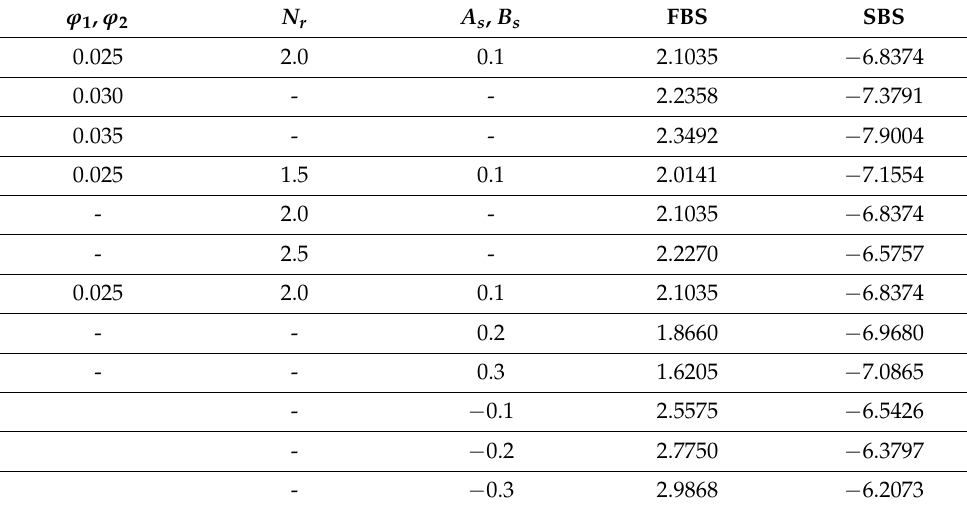
Table 6. Quantitative values of the HTR for the several distinct parameters when ε c = −